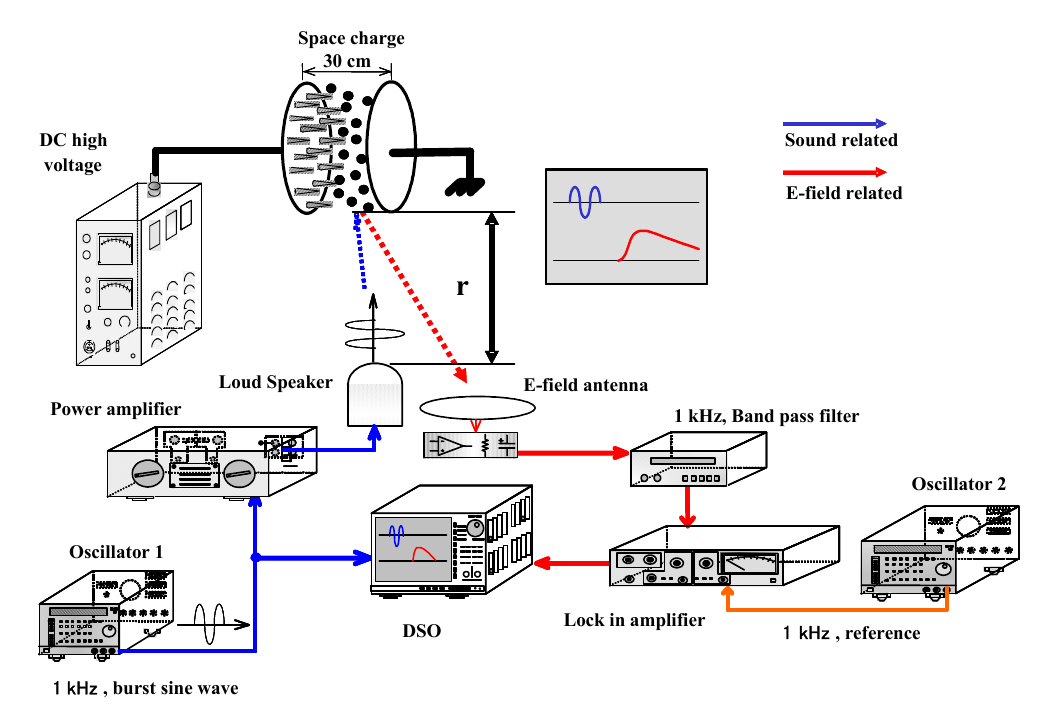
Figure 2 . A schematic illustration of the setup for measuring space charge in laboratory.